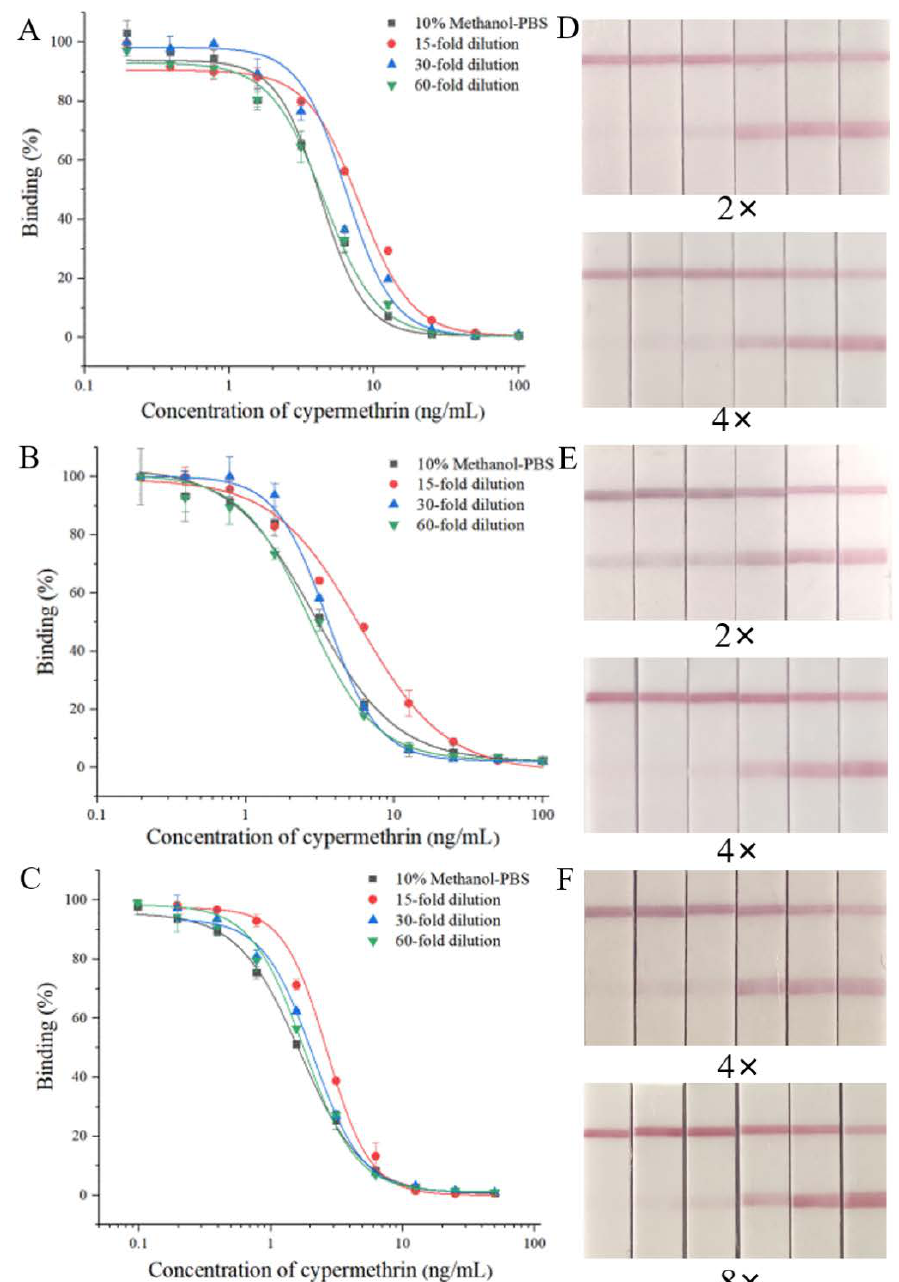
Figure 4. The matrix effects of ic-ELISA and LFIA. The matrix effects on ic-ELISA: ( A ) cabbage; ( B ) tomato; ( C ) romaine lettuce. The matrix effects on LFIA: ( D ) cabbage ( E ) tomato; ( F ) romaine lettuce; the concentrations from left to right are 0.6, 0.5, 0.4, 0.3, 0.2 and 0 μg/mL.